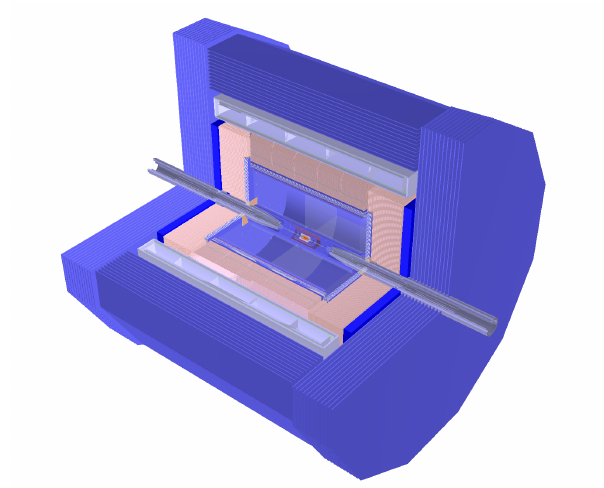
Figure 3 . The CEPC baseline detector [4]. From inner to outer, the detector is composed of a silicon pixel vertex detector, a silicon inner tracker, a TPC, a silicon external tracker, an ECAL, an HCAL, a solenoid of 3 Tesla and a return yoke embedded with a muon detector. In the forward regions, five pairs of silicon tracking disks are installed to enlarge the tracking